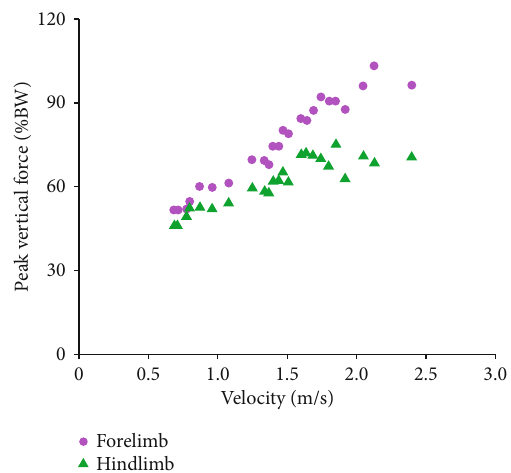
Figure 4: Scatter diagram of PVF to